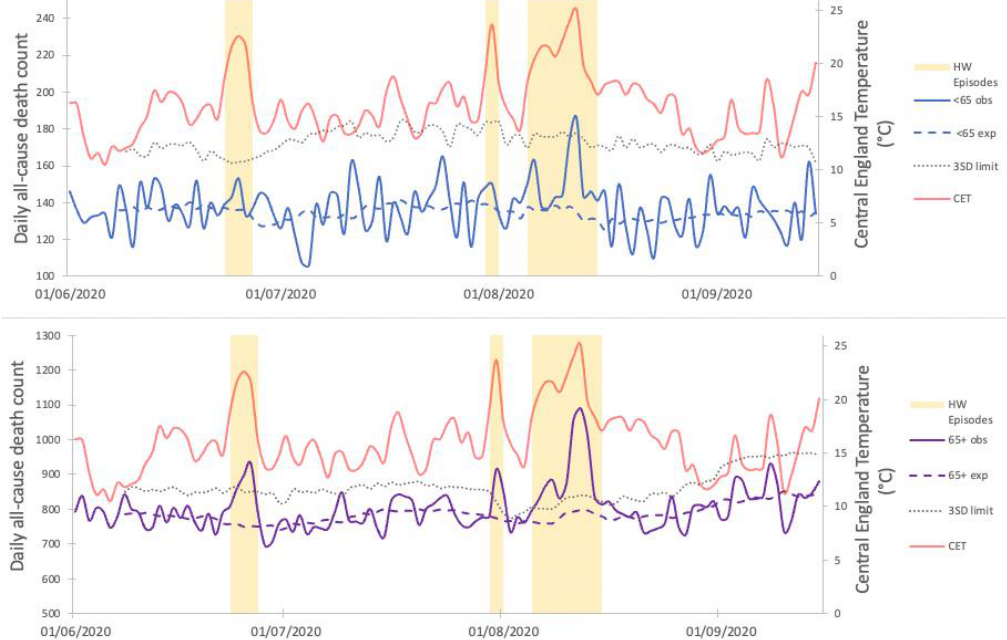
Figure 2. Three mortality peaks associated with the heatwave events identified for both the <65 years group (top panel) and the 65+ years group (bottom panel). Both panels also display the calculated daily expected deaths (dashed lines) and the 3 standard deviation threshold used to determine significance (dotted line). Heatwave episodes are highlighted on both panels with CET included for context.